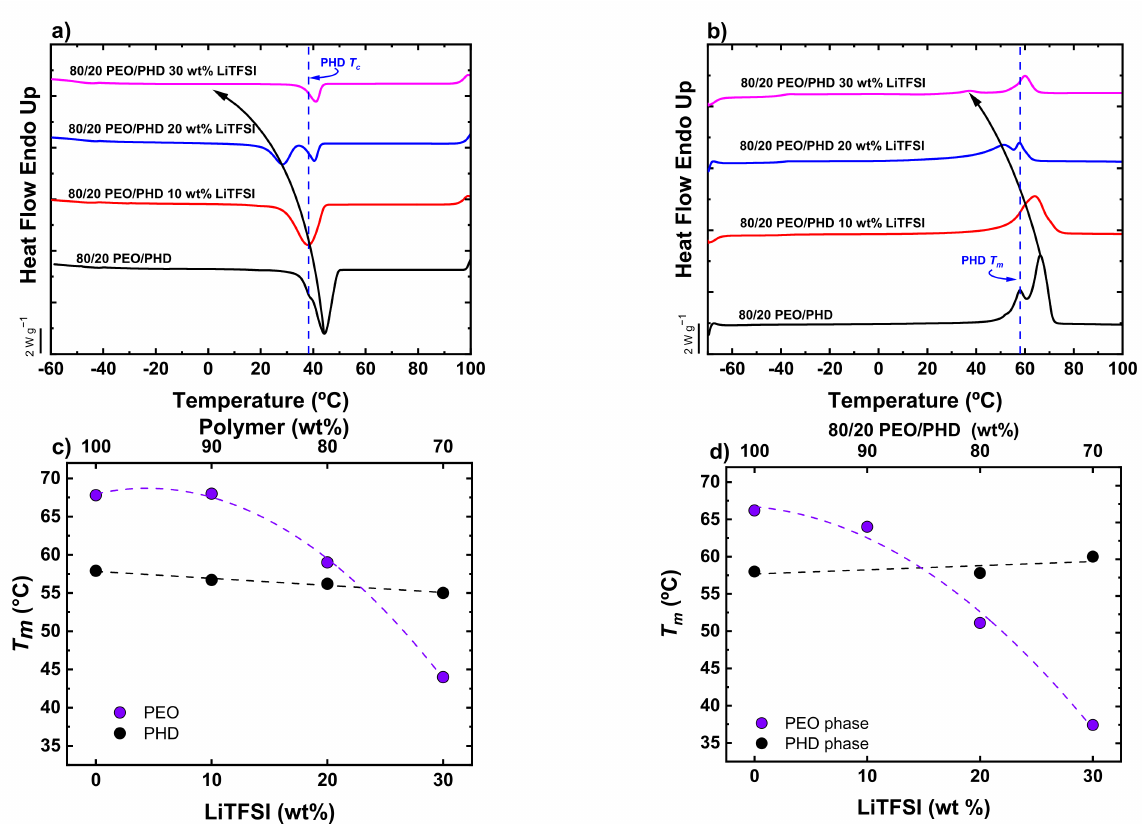
Figure 5. DSC for the PEO/PHD blends: ( a ) during cooling from the melt, ( b ) subsequent melting scans, ( c ) change in T m for the PEO and PHD homopolymers as a function of LiTFSI concentration, ( d ) change in T m for the PEO and PHD phases within the 80/20 PEO/PHD as a function of LiTFSI